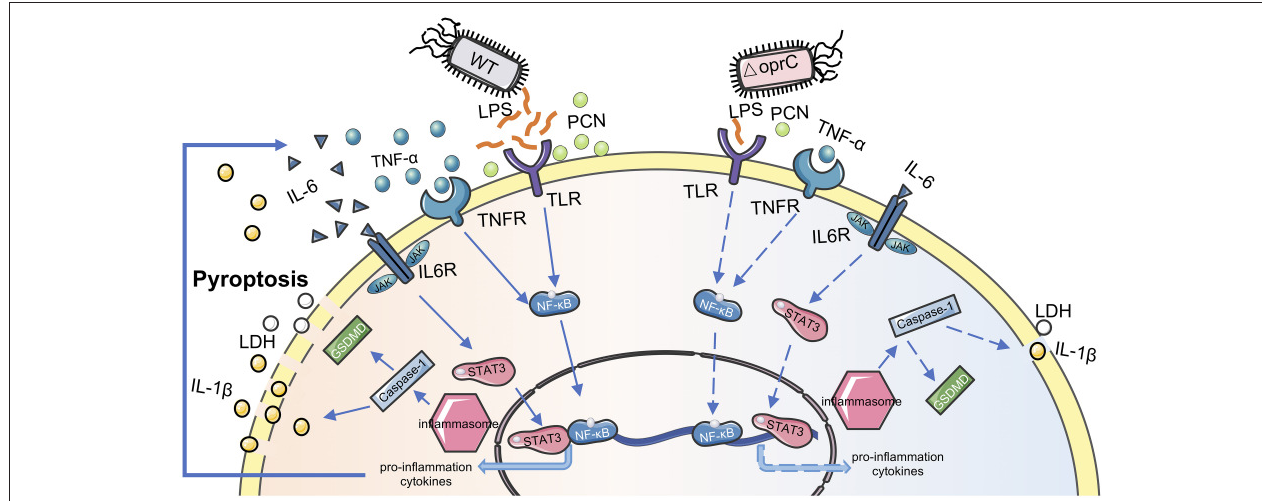
FIGURE 7 | Proposed model for oprC- mediated virulence regulation. Compared with P. aeruginosa wild type PAO1, less virulent 1 oprC secretes less LPS and PCN, attenuating host receptor recognition following transcription factor activation. Less proinflammation cytokine secretion and weaker membrane recognition occur during 1 oprC infection. Finally, oprC deficiency decreases the pyroptosis induced by P. aeruginosa